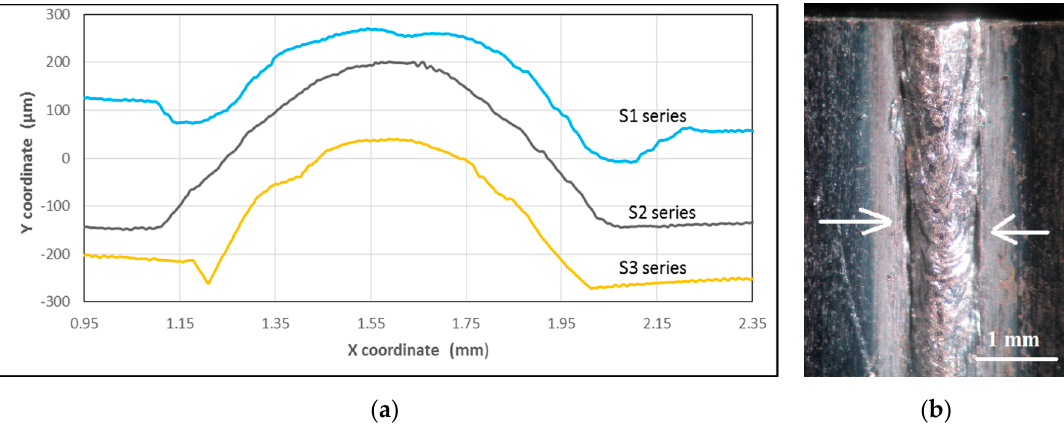
Figure 7. Appearance of weld roots and undercuts for S1, S2 and S3 series: ( a ) captured by profilometer; ( b ) photograph .